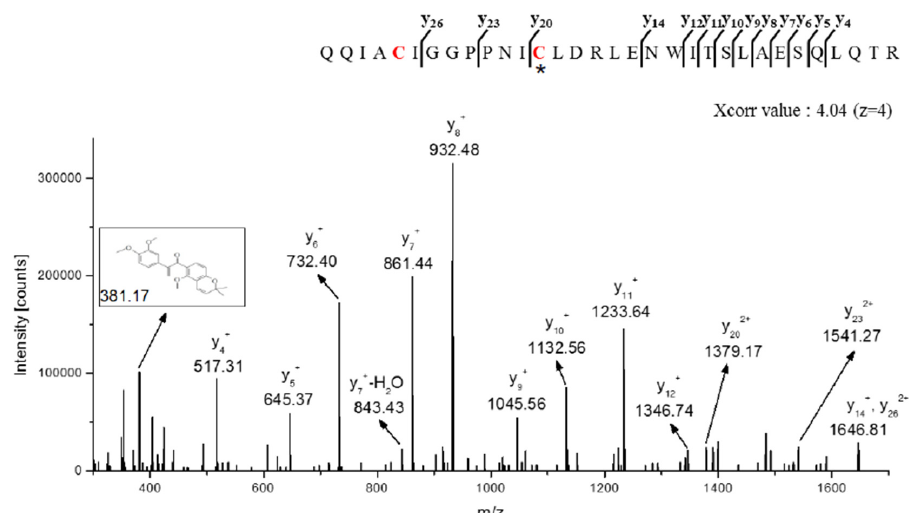
Figure 6. Mass spectrometric analysis of STAT3 modified by SH48. Mass spectrum of the STAT3 peptide (QQIACIGGPPNI C 259 LDRLENWITSLAESQLQTR) with SH48 binding. The annotated tandem mass spectroscopy (MS/MS) spectrum illustrating the binding of SH48 to STAT3 protein at cysteine 259 residues was identified by liquid chromatography–tandem mass spectroscopy (LC-MS / MS). Each symbol present with b and y ions on the spectrum represents the SH48 fragment ion bound to Cys259. *C denotes Cys259 modified by